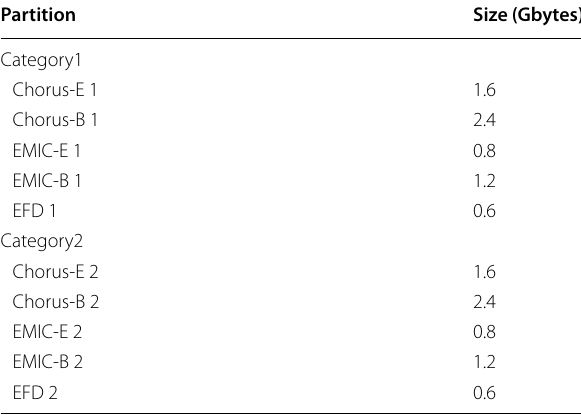
Table 5 The configuration of the MDR partition Table 6 A list of auto-triggering conditions for